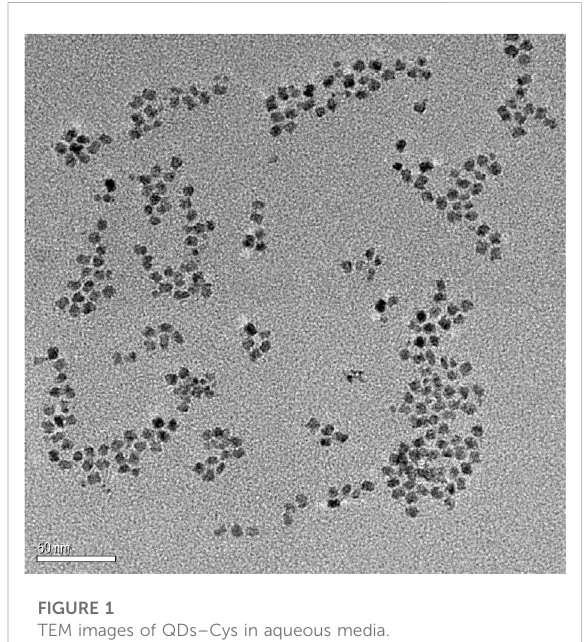
FIGURE 1 TEM images of QDs – Cys in aqueous